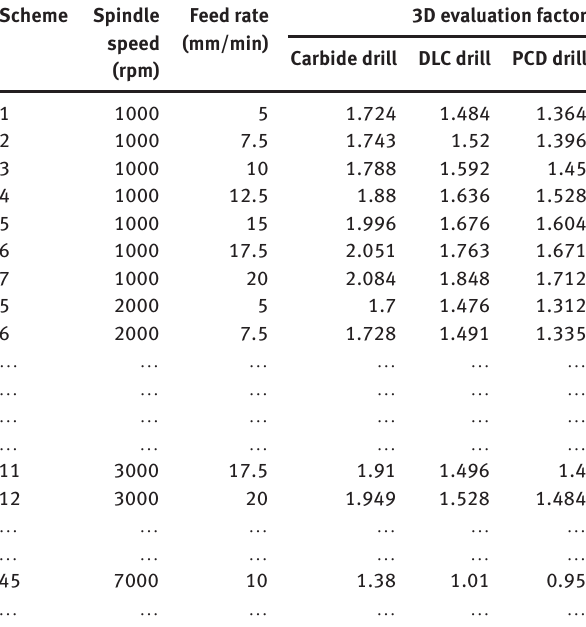
Table 2: Various drilling schemes and the 3D evaluation factor responses. Scheme